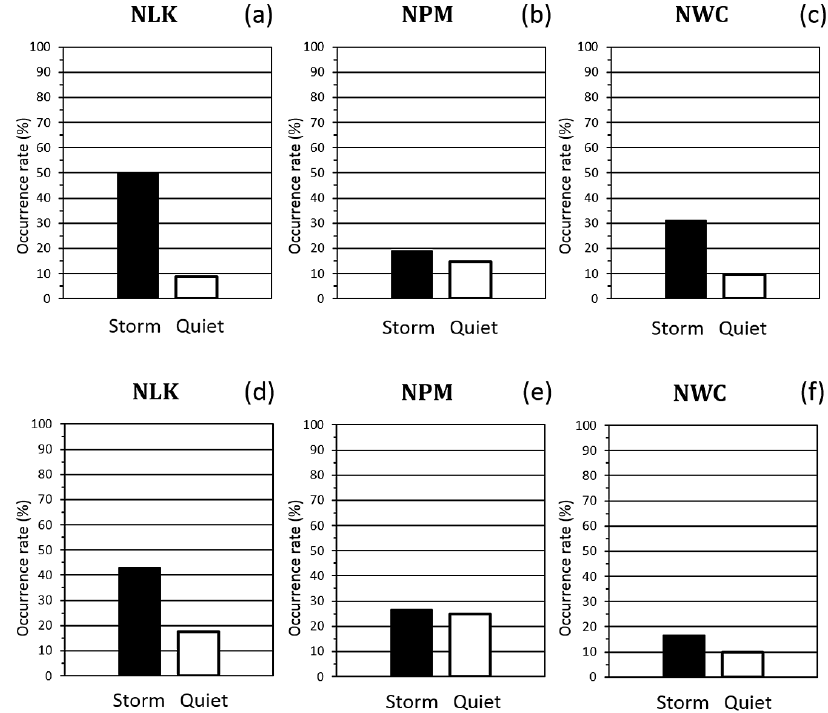
Figure 4. Histograms summarizing the statistical results for the case A. Every histogram contains the occurrence rate of VLF anomaly based on different statistical parameters for storm time and geomagnetically quiet time periods. (a) NLK, (b) NPM, (c) NWC for 2012, (d) NLK, (e) NPM, (f) NWC for